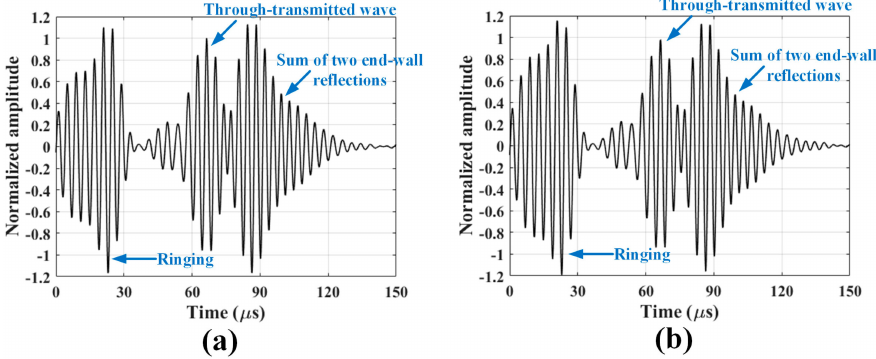
Figure 10. Normalized SH wave signals collected at ( a ) prior to exposure and ( b ) 16 h of gamma radiation exposure.